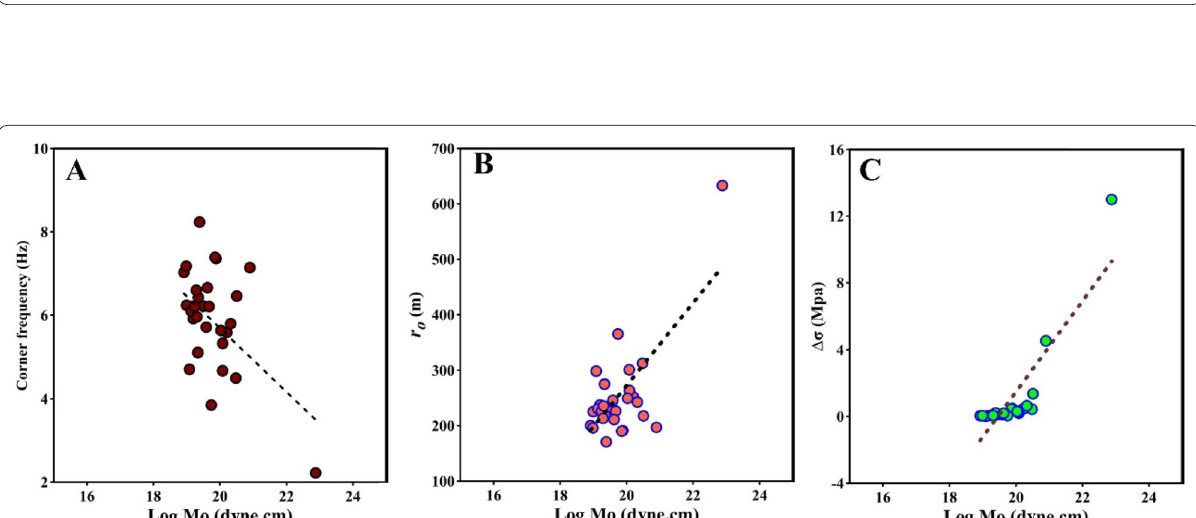
Fig. 9 Regression analysis between the local magnitude assigned by the ENSN and the logarithm of the seismic moment ( A ) and their linear relation with the moment magnitude obtained for the current events ( B )